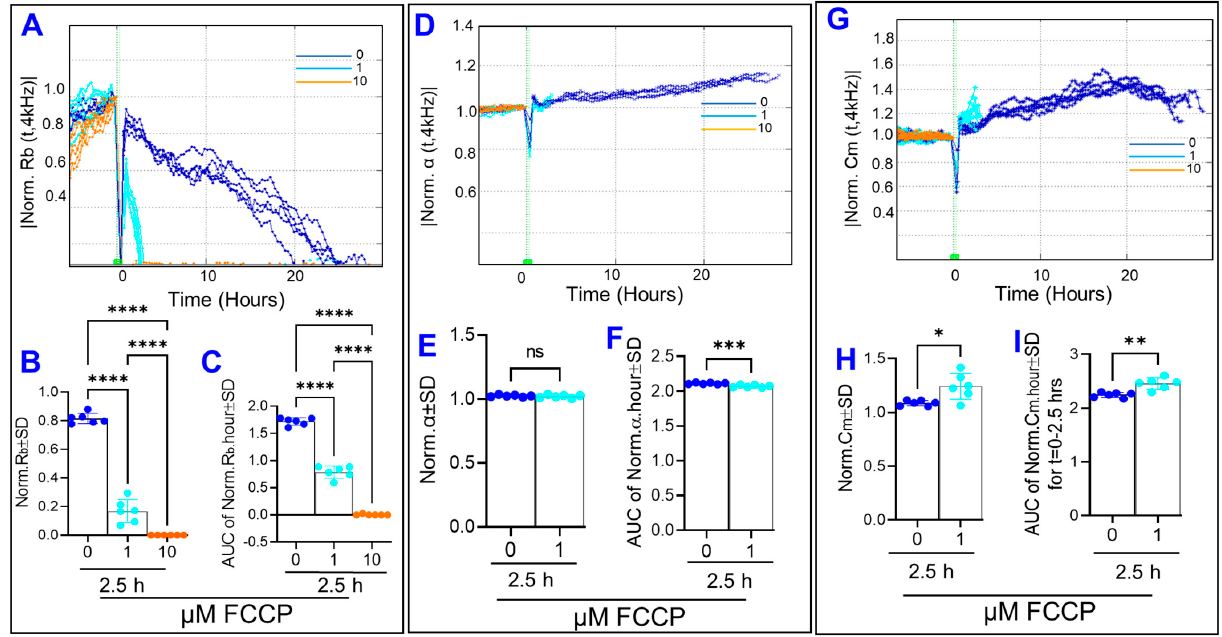
Figure 4. Real-time monitoring of human retinal endothelial cells’ α , R b , and C m treated with OxPhos uncoupler (FCCP). ( A ) Normalized R b curve measured at 4000 Hz vs. time (t). ( B ) The bar graph represents normalized R b measured at t = 2.5 h. ( C ) AUC of normalized R b measured between 0 and 2.5 h. ( D ) Normalized α curve measured at 4000 Hz vs. time (t). ( E ) The bar graph represents normalized α measured at t = 2.5 h. ( F ) AUC of normalized α measured between 0 and 2.5 h. ( G ) Normalized C m curve measured at 4000 Hz vs. time (t). ( H ) The bar graph represents normalized C m measured at t = 2.5 h. ( I ) AUC of normalized C m measured between 0 and 2.5 h. Statistical analysis was performed using the ANOVA test followed by the Tukey post hoc test. Abbreviations: Norm, normalized; AUC, area under the curve; ns, no significance; *, p ≤ 0.05; **, p ≤ 0.01; ***, p ≤ 0.001; ****, p ≤ 0.0001; n = 5–6/group.